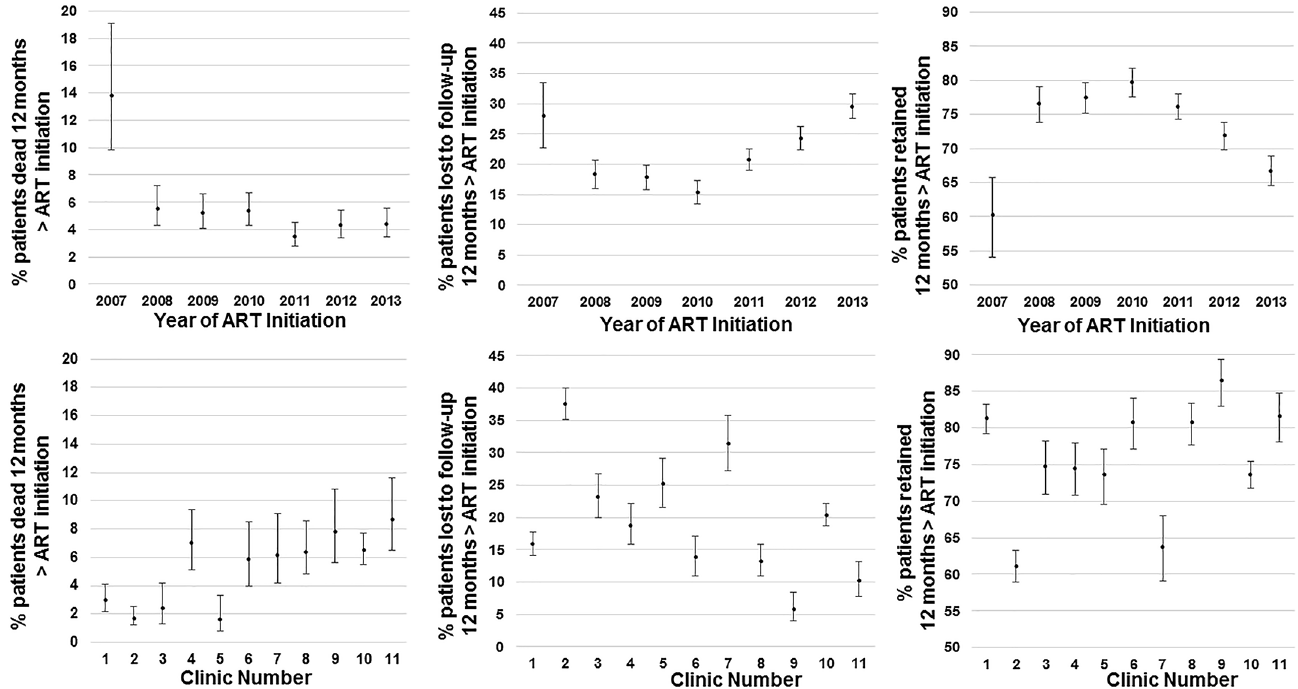
Fig 2. Death, lost to follow-up and retention at 12-months after ART initiation among adults initiating ART in GHESKIO-MSPP facilities in Haiti from 2007 to 2013. Median point estimates are plotted with 95% ConfidenceInterval bars.